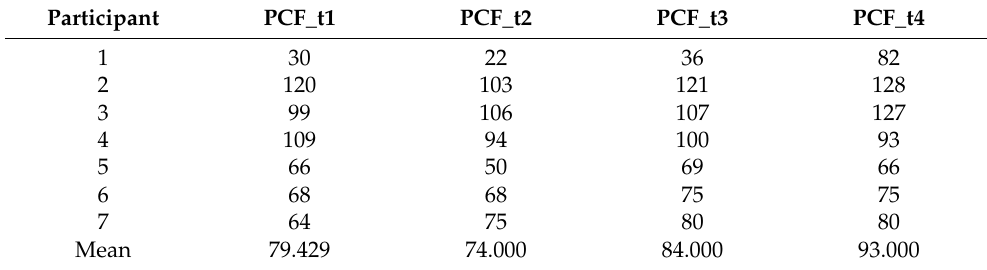
Table 6. PEF (%) individual and mean measurements at four assessment time